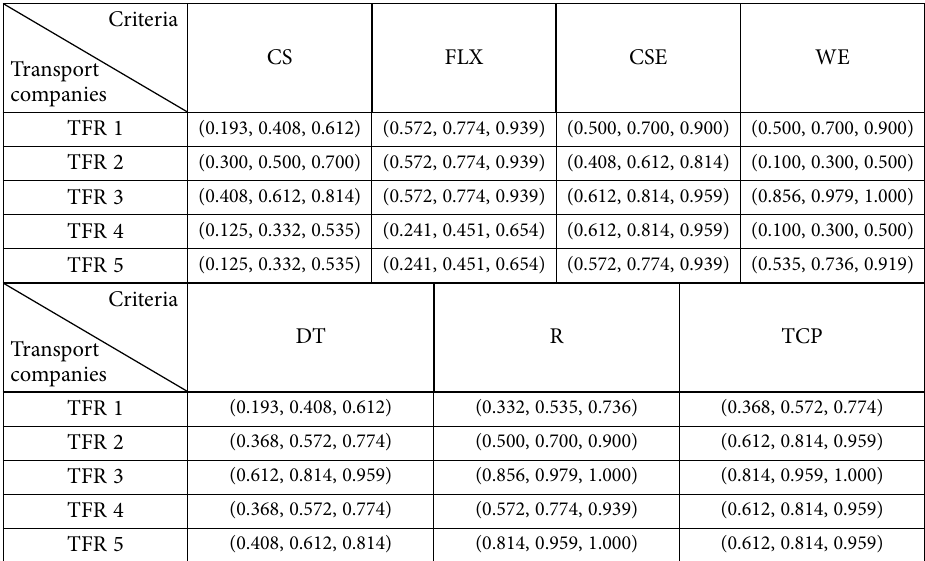
Table 9. The fuzzy decision matrix